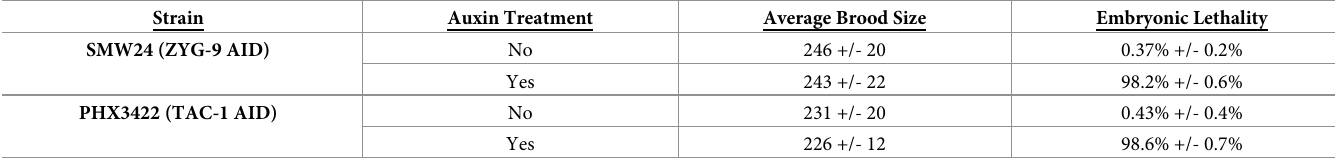
Table 3. Embryonic Lethality Assays of AID strains.